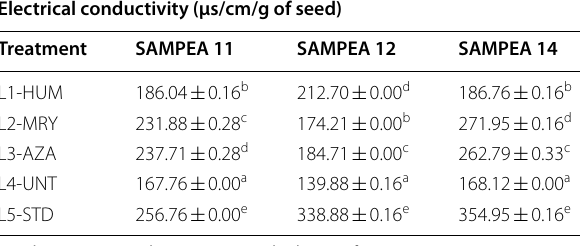
Results are expressed as mean standard error of mean ± Values with different superscripts in a column are significantly ( P < 0.05) different